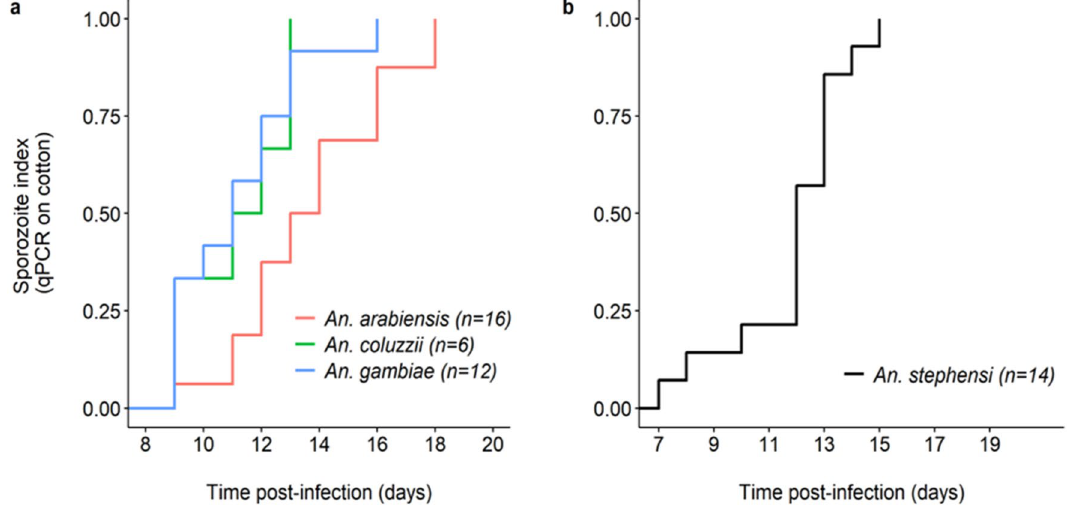
Figure 2. The extrinsic incubation period of Plasmodium falciparum in four Anopheles mosquito species. ( a ) Kaplan–Meier curves representing the temporal dynamics of sporozoite appearance in small pieces of cotton used to collect saliva from individual mosquitoes in the three major African vectors An. arabiensis (red) , An. gambiae (blue) and An. coluzzii (green). ( b ) Same as ( a ) but for An. stephensi . The numbers in brackets indicate the number of females for each species of mosquito that generated at least one positive cotton. African vectors were infected with the P. falciparum isolate C and An. stephensi with the NF54 laboratory